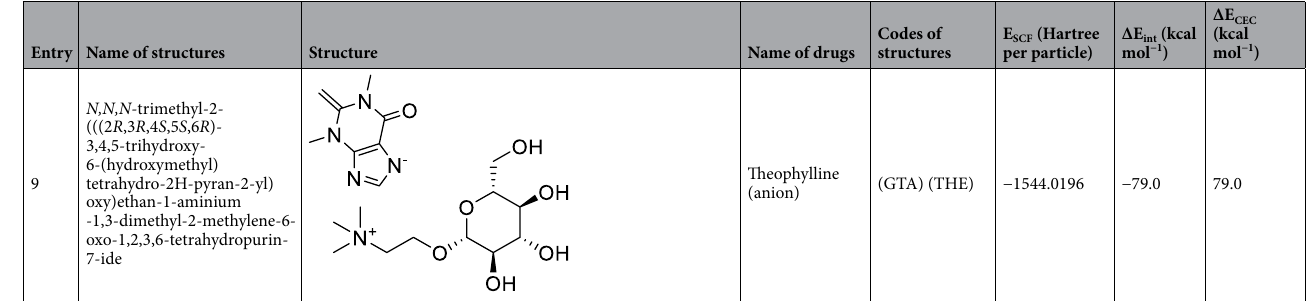
Table 2. ΔE int and ΔE CEC (kcal mol −1 ) of ionic liquids based on N,N,N -trimethyl-2-(((2 R ,3 R ,4 S ,5 S ,6 R )-3,4,5- trihydroxy-6- (hydroxymethyl)tetrahydro-2H-pyran-2-yl)oxy)ethan-1-aminium (GTA), calculated at the B3LYP/6-311++G(d,p)